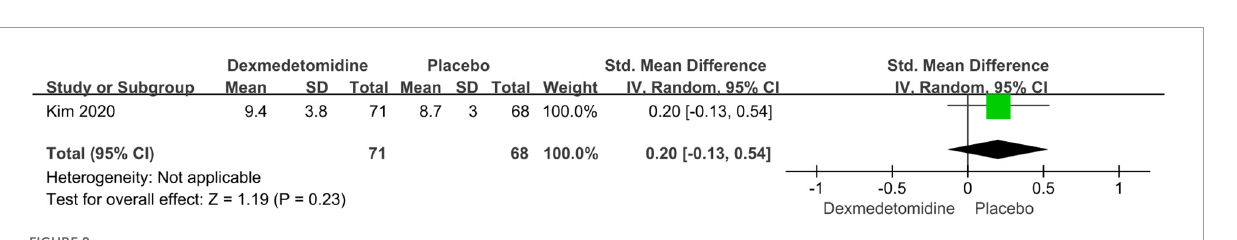
FIGURE8 Pooled result of postoperative length of hospital stay between dexmedetomidine and placebo